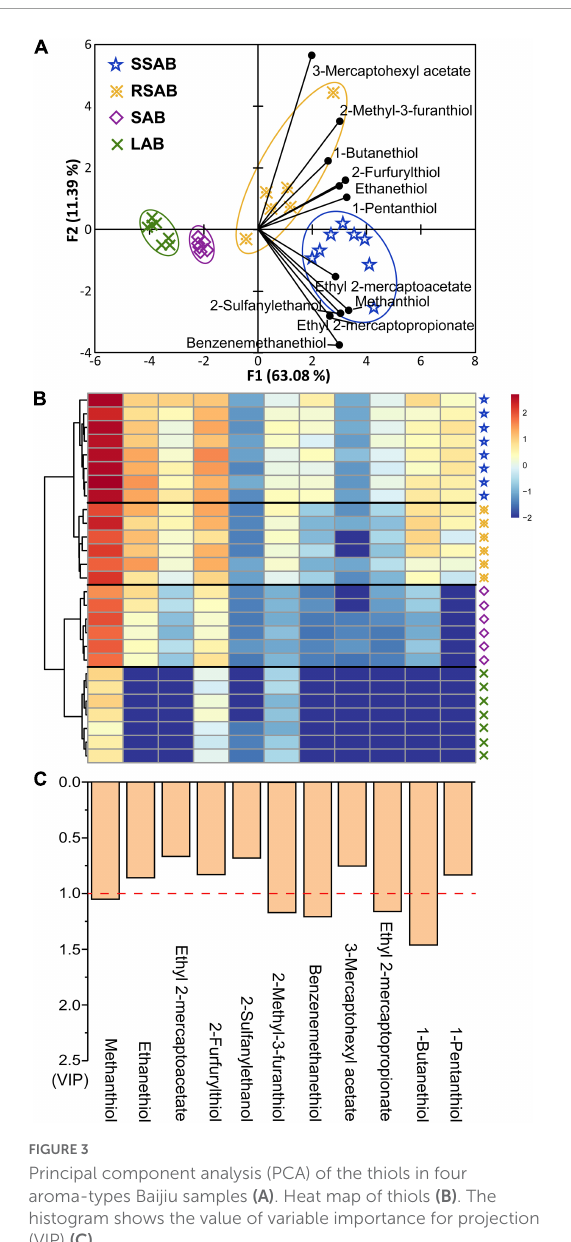
FIGURE3 Principal component analysis (PCA) of the thiols in four aroma-types Baijiu samples (A) . Heat map of thiols (B) . The histogram shows the value of variable importance for projection (VIP) (C)